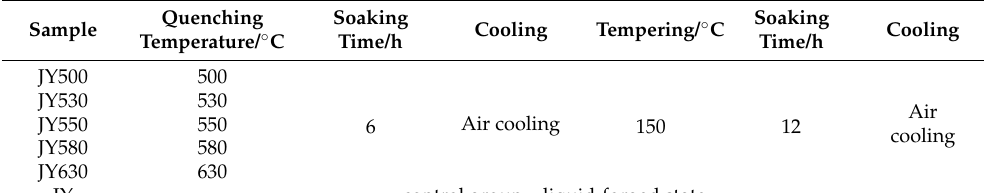
Table 4. Experimental scheme of subcritical quenching.